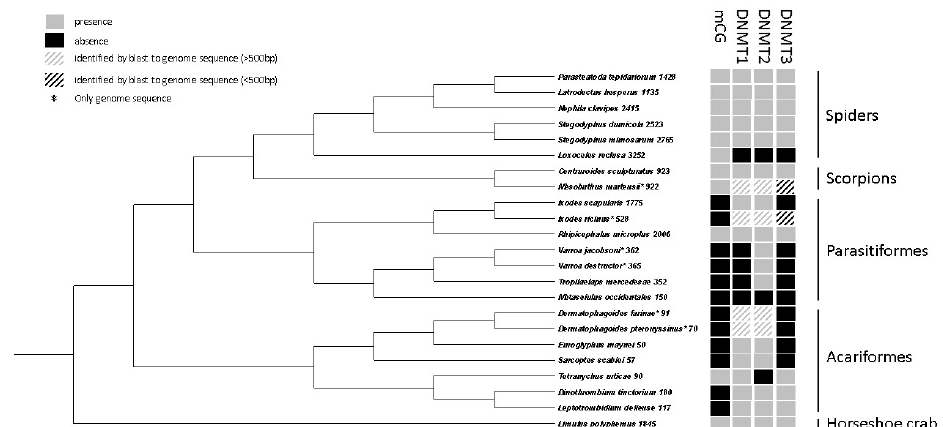
Figure 4. The presence/absence of indirectly inferred DNA methylation (CpG O/E ), DNMT1, DNMT2, and DNMT3 in previously sequenced chelicerate genomes. The cladogram was schematically put together from several lines of evidence (see Materials and methods Section 2.9.).